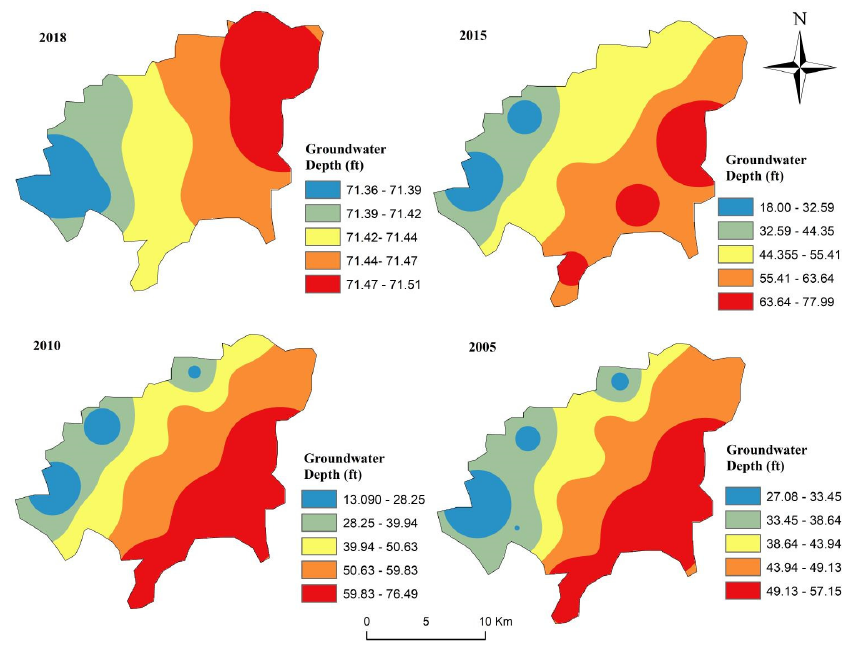
Figure 13. Spatial variability in post-monsoon water table depth from 2005 to 2018.